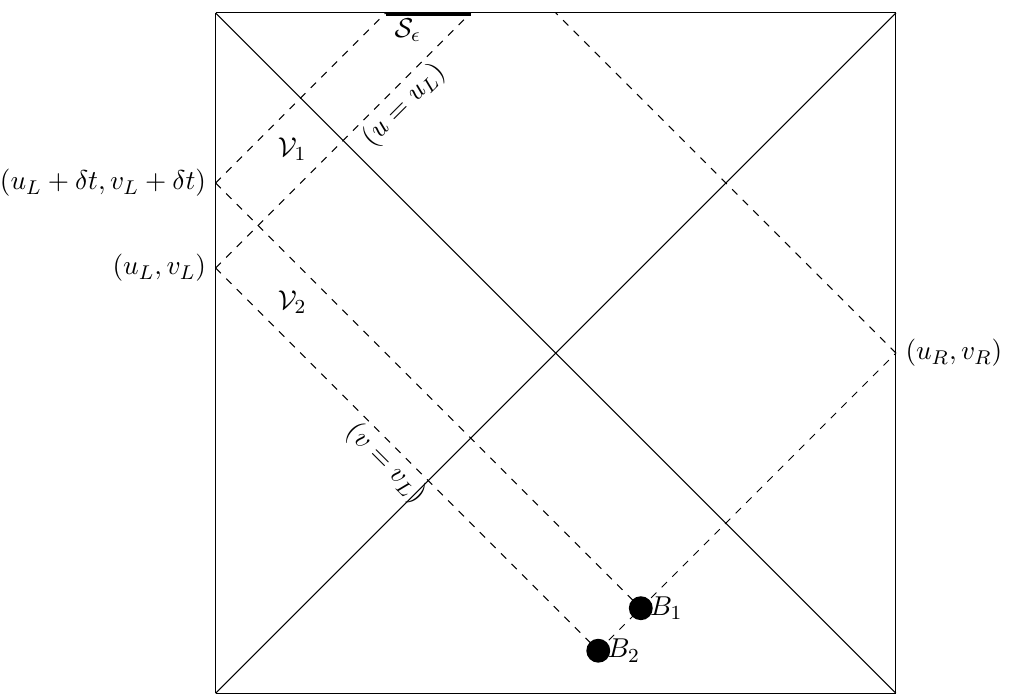
Figure 1 . Two WDW patches separated by (cid:14)t . Although the boundary of each patch is really at some large but (cid:12)nite r b , the choice of r b drops out in the di(cid:11)erences we consider and we do not indicate it explicitly in this